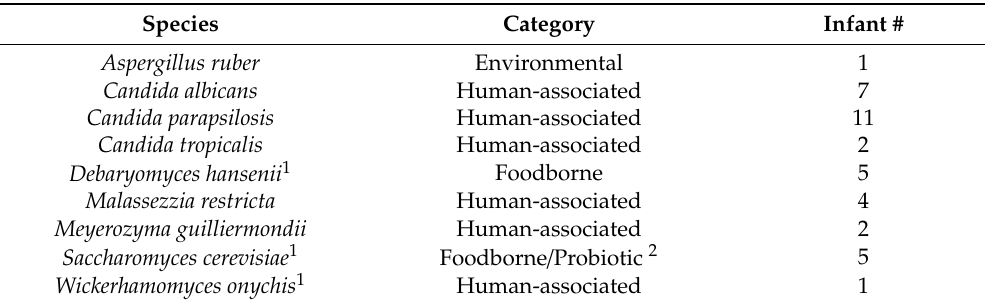
Table 1. Persistent fungi. Species detected at two or more collection timepoints (i.e., at 6-, 12- and / or 18-months), with the ability to grow at body